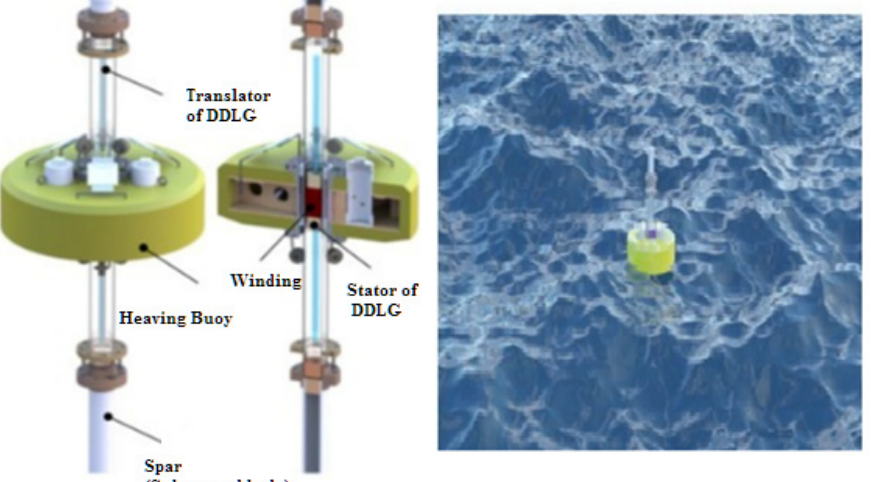
Figure 26. Smart wave energy converter [133].